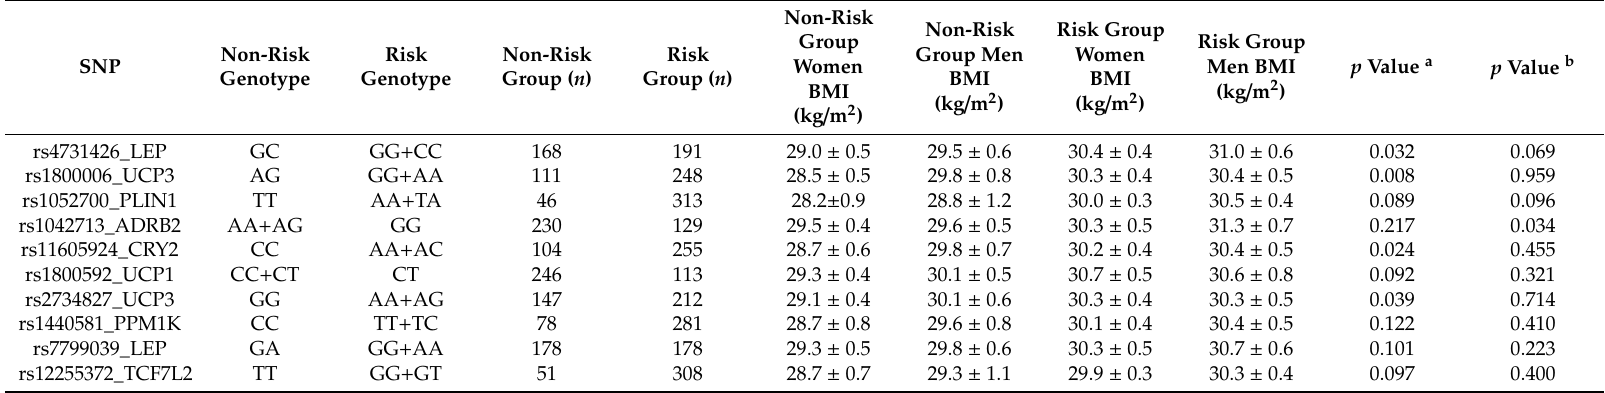
Table 2. Genotype codifications of the 10 single specific SNPs statistically or marginally associated in this population with BMI, which were used for the calculation of the Genetic Risk Score. Values correspond to the mean ±